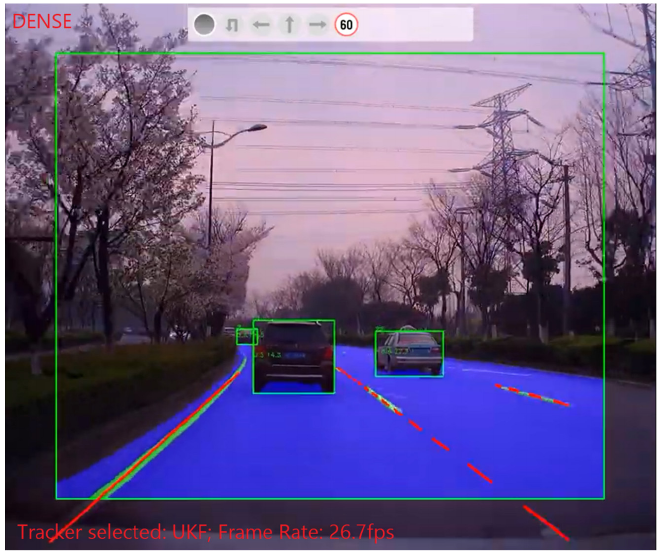
Figure 18. Image taken at t = 12.33 s. Traffic state: Dense. Tracker—UKF.